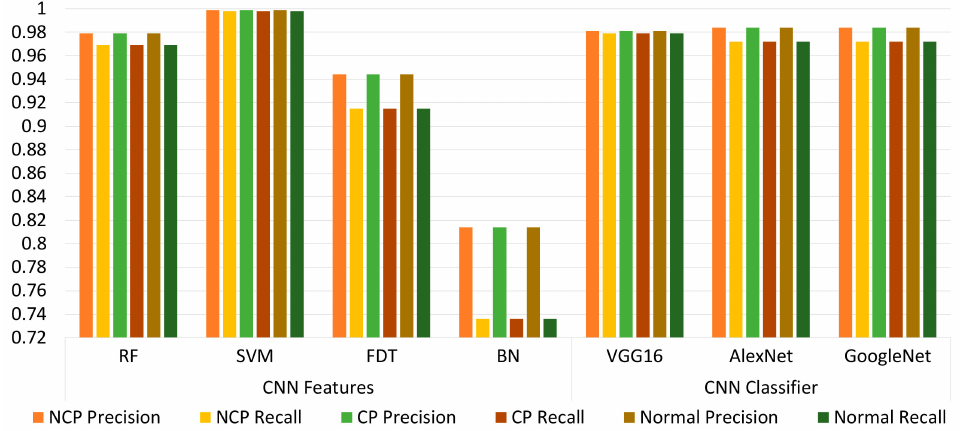
Figure 8. Precision- and recall-based comparison of the proposed method with well-known CNN